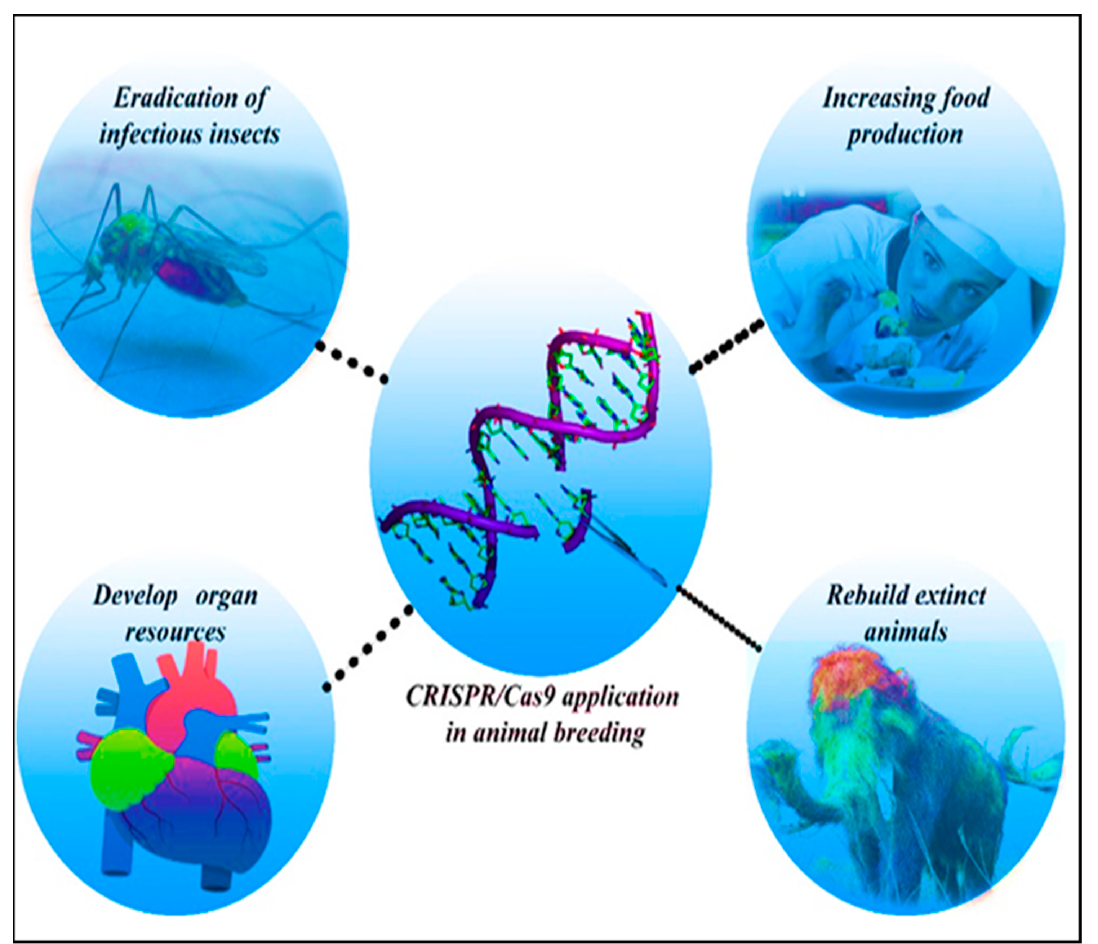
Figure 3. Exploitation of CRISPR-Cas9 in animal breeding and animal models.